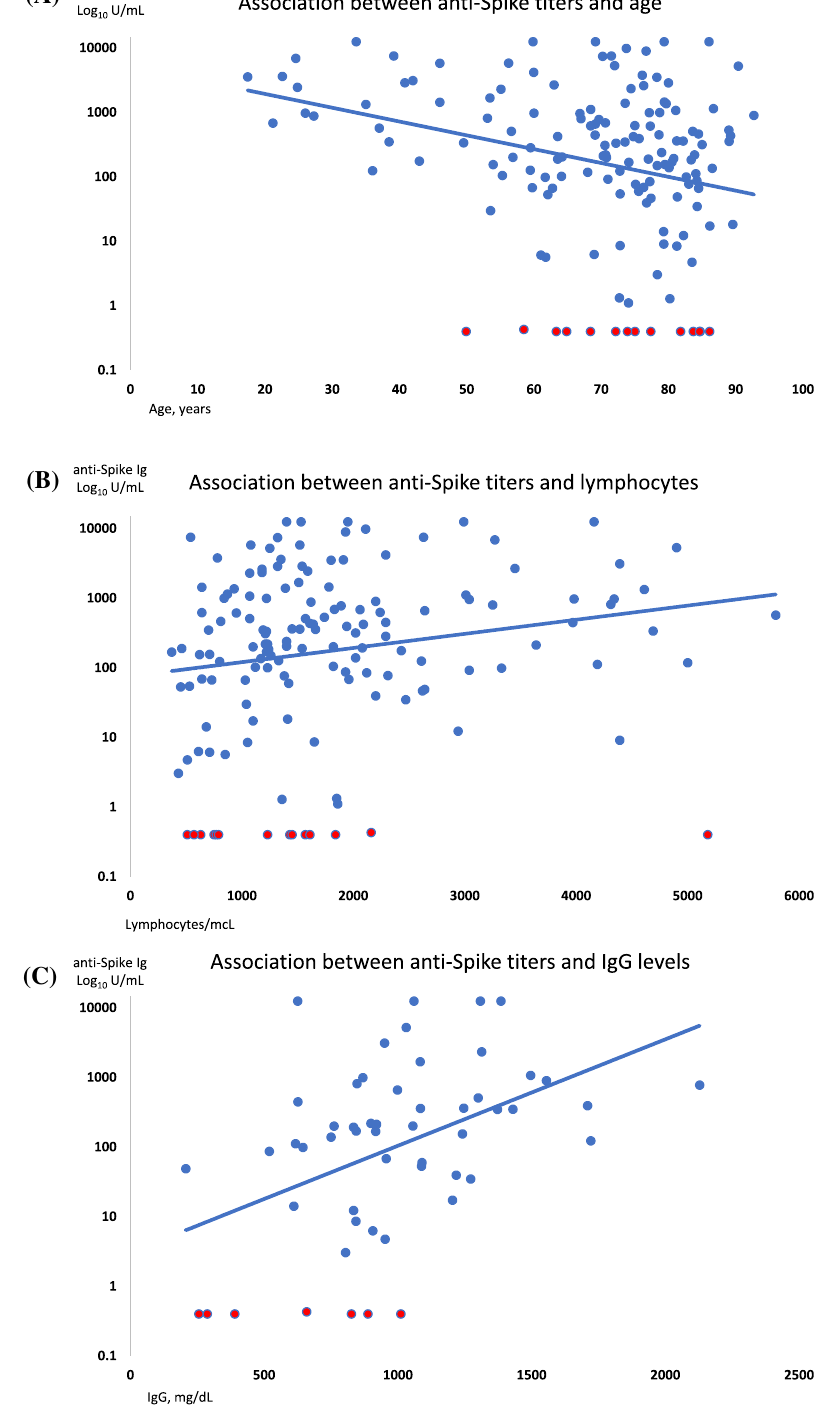
Figure 2. Association among anti-Spike IgG titers and age ( A ), peripheral lymphocyte counts ( B ), and total IgG levels ( C